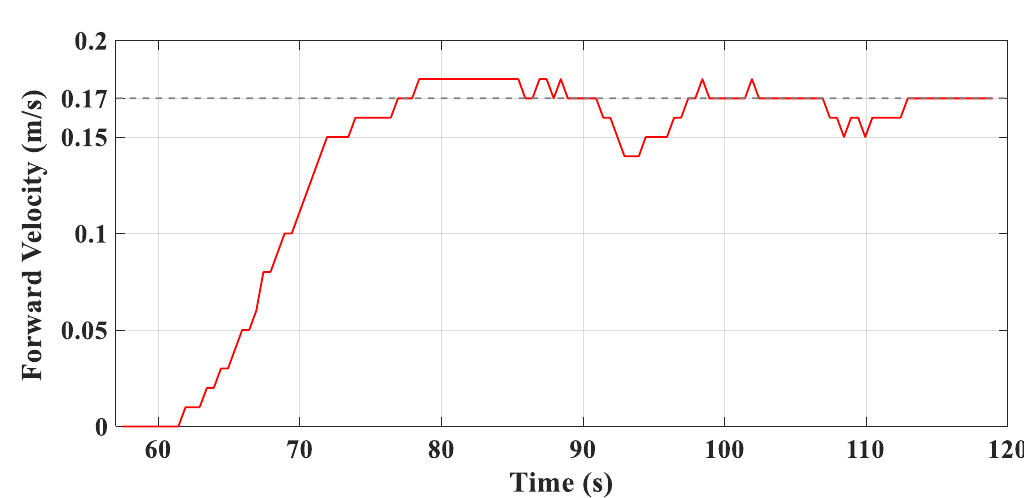
Figure 17. Ballast mass tracking error of depth control via on-off type VBS.